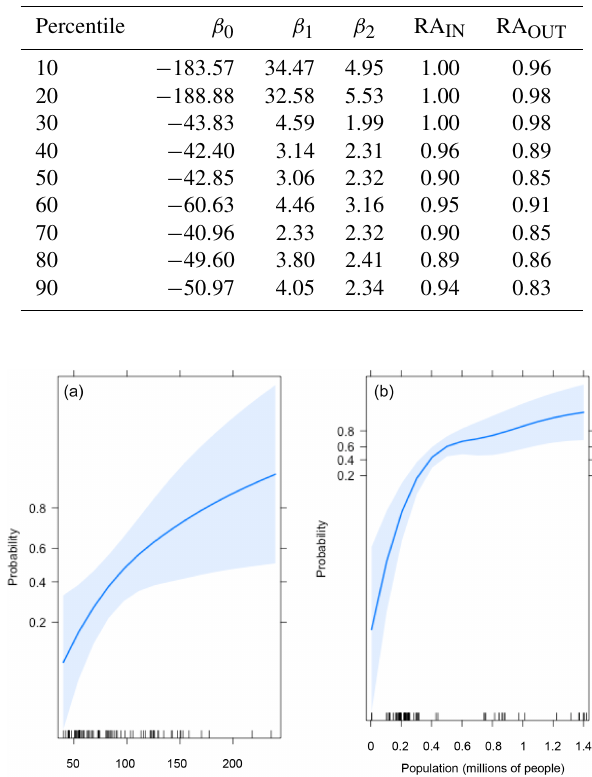
Table 4. Parameters of the generalized linear mixed model and the area under the ROC curve (RA IN : in-sample validation; RA OUT : out-of-sample validation) values for all the percentiles of damage for the Valencian Community. β 0 , β 1 and β 2 represent the regression coefficients of the model (intercept, precipitation and population, respectively). In this case, all the regression coefficients are statistically significant ( p value < 0.05).